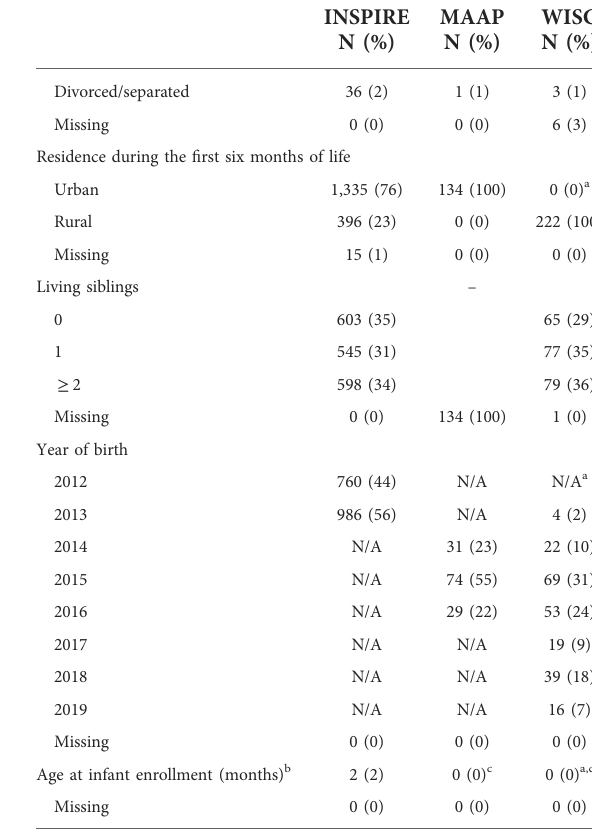
TABLE 1 Demographic and clinical characteristics of the study populations with linked newborn screening data and non-missing outcome